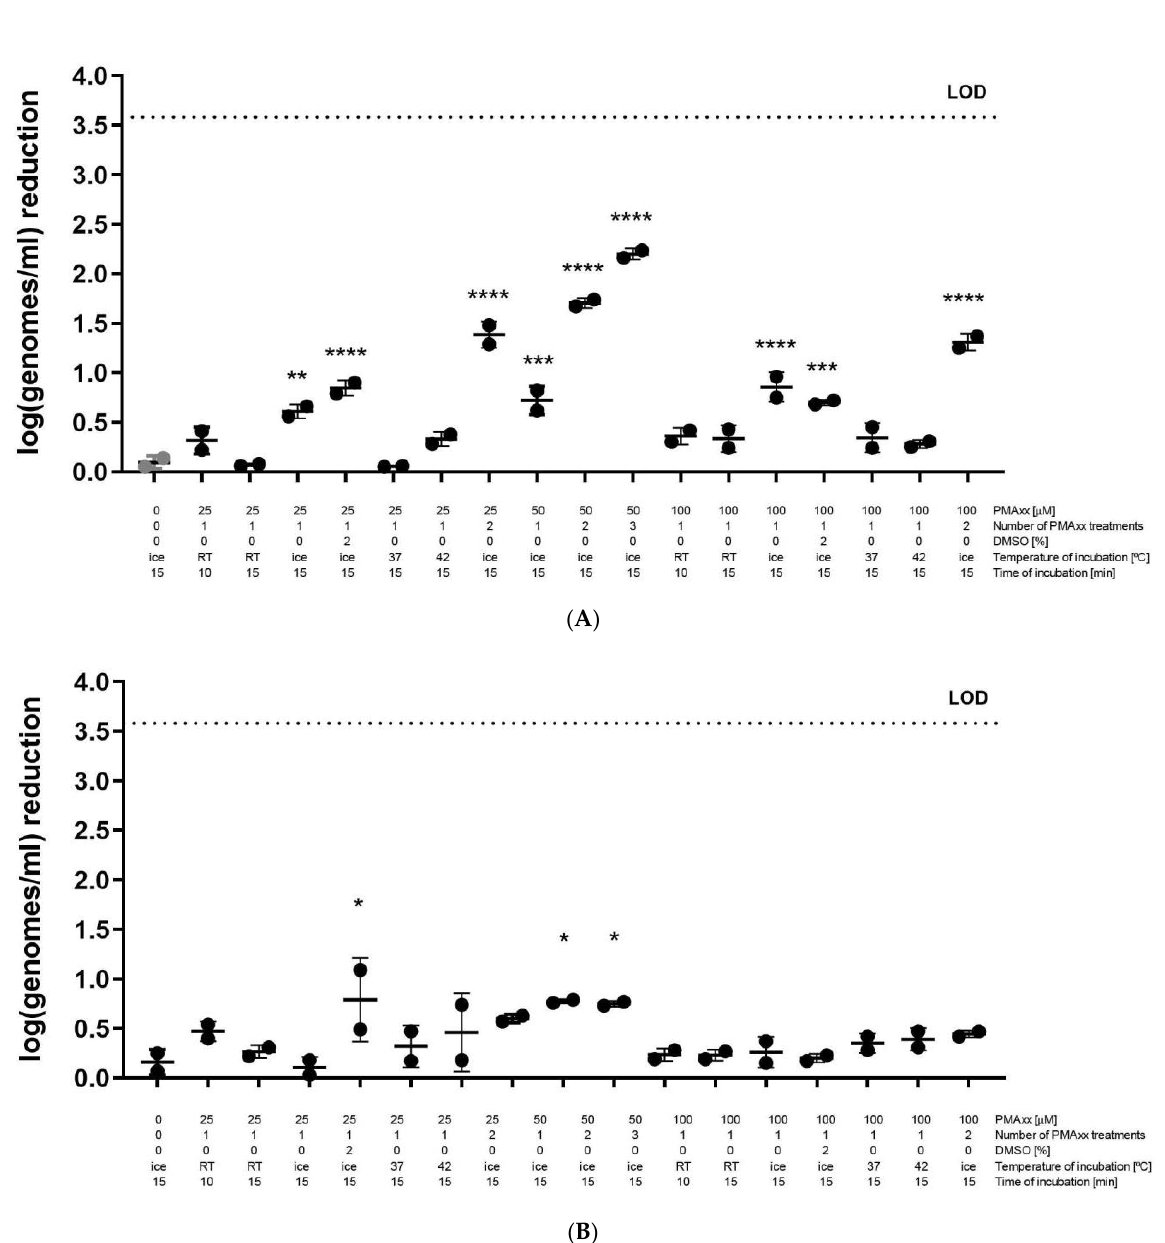
Figure 1. ( A ) Reduction of cells (log genomes/mL), killed by 0.05 mg/mL PM-477 during overnight anaerobic incubation at 37 °C in 75% humidity, as assessed by different PMAxx treatment conditions of the killed cells, followed by DNA extraction and Gardnerella swidsinskii specific qPCR. Values are calculated as: log(number of MES-treated PMAxx-treated genomes/number of PM-477-killed PMAxx-treated genomes). ( B ) Reduction of cells (log genomes/mL), not treated with PM-477, i.e., reduction due to PMAxx treatment itself. Values are calculated as: log(number of MES-treated PMAxx-non-treated genomes/number of MES-treated PMAxx-treated genomes). Grey dots repre- sent samples on which PMAxx treatment was not performed, black dots represent samples on which different PMAxx treatments were performed. *: p - value < 0.05; **: p -value < 0.01; ***: p - value < 0.001; ****: p - value < 0.0001, as assessed by one - way ANOVA followed by Tukey’s multiple com- parisons test in GraphPad Prism 9. Asterisks indicate statistically significant difference between samples treated with PM-477 and inactivated by PMAxx treatment (black dots) and samples treated with PM-477 only (grey dots, 1A). B. Asterisks indicate statistically significant difference between samples treated with MES and inactivated by PMAxx treatment and samples treated with MES only (assumed to be 0).